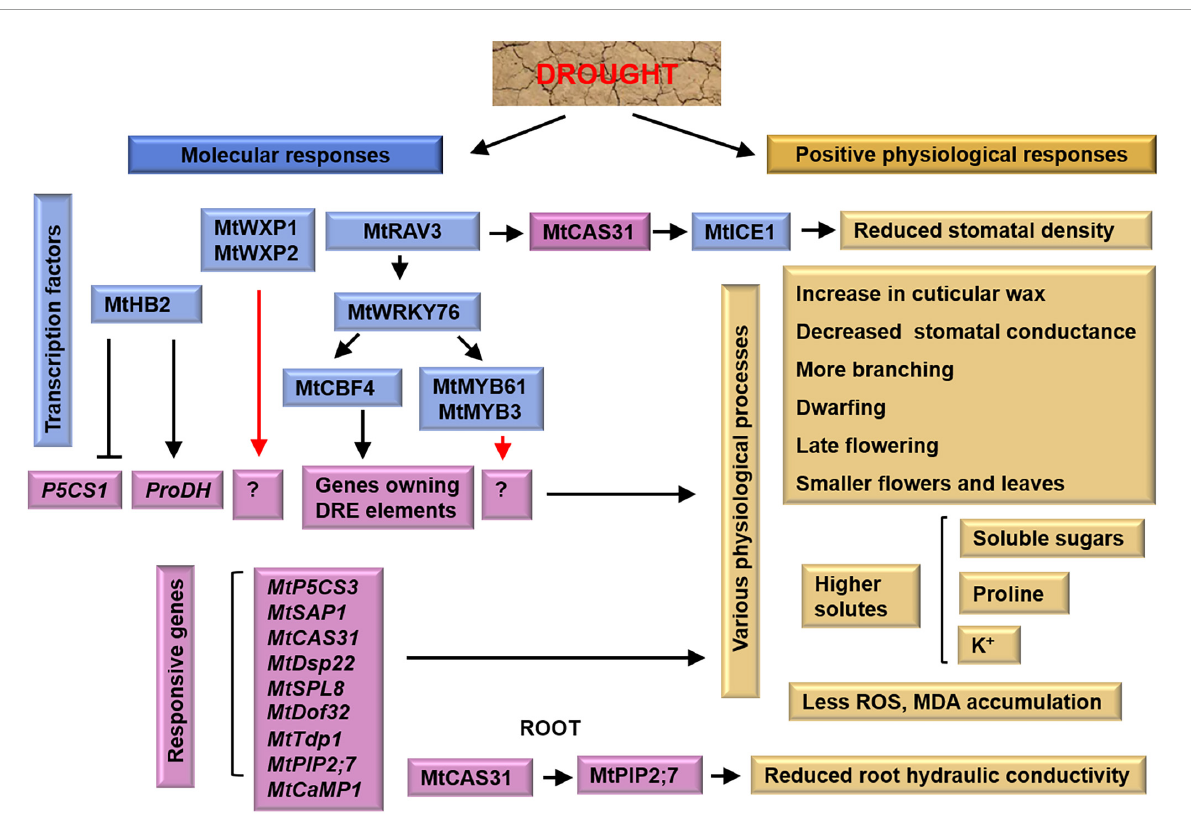
FIGURE1 Tolerant mechanism of M. truncatula to drought stress. In shoots, MtRAV3 induces the expression of MtCAS31 , whose encoded protein binds with MtICE1, resulting in reduced stomatal density. In roots, MtCAS31 facilitates the autophagic degradation of aquaporin MtPIP2; 7, and reduces root hydraulic conductivity. Blue boxes and purple boxes indicate transcription factors and responsive genes, respectively. Yellow boxes indicate physiological responses of M. truncatula . The black arrows represent the targets, the red arrows represent the unknown factors and the cross-lines mean